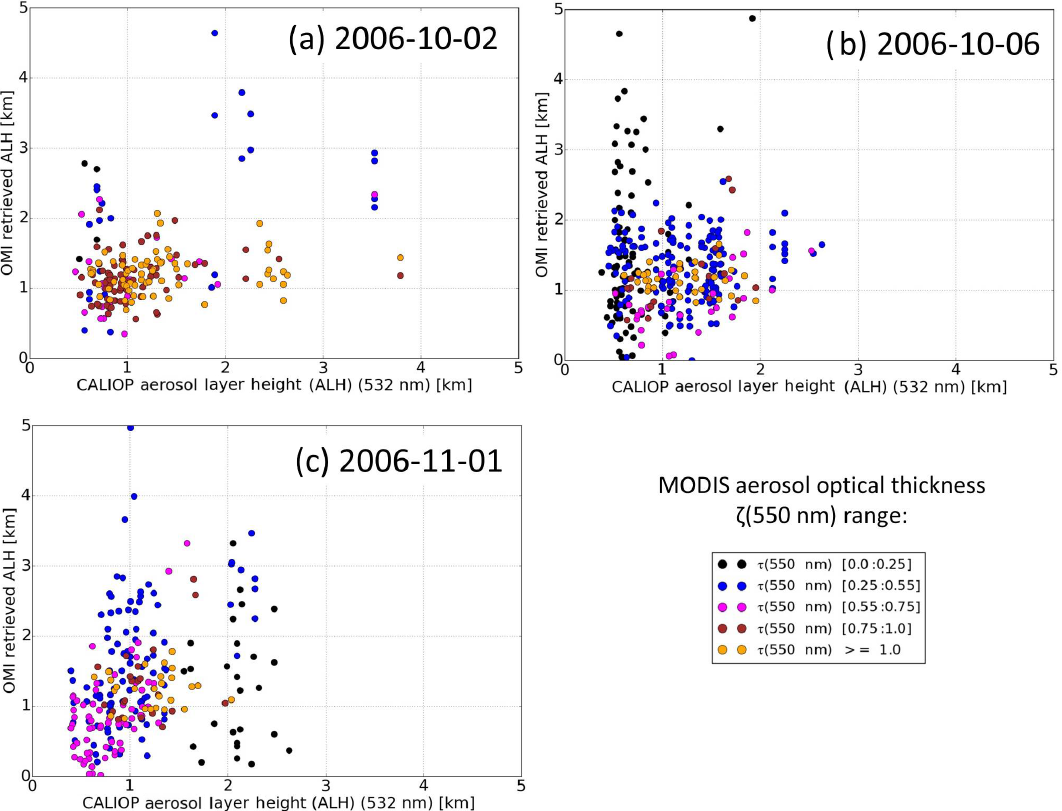
Figure 5. Scatter-plot of collocated retrieved OMI ALH and derived CALIOP ALH (532nm) (see Sect. 4.1) for urban and industrialized cases over eastern China as a function of MODIS τ( 550nm ) . Distance between OMI and CALIOP pixels is 50km: (a) 2 October 2006, (b) 6 October 2006, and (c) 1 November